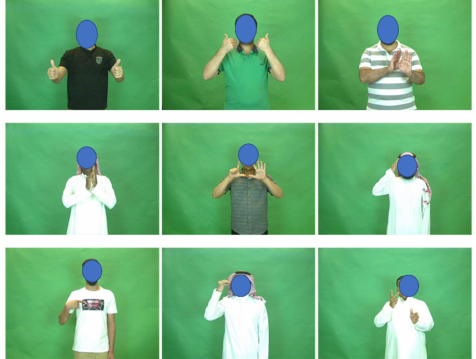
Figure 1. Sample frames from the KSU-SSL dataset.